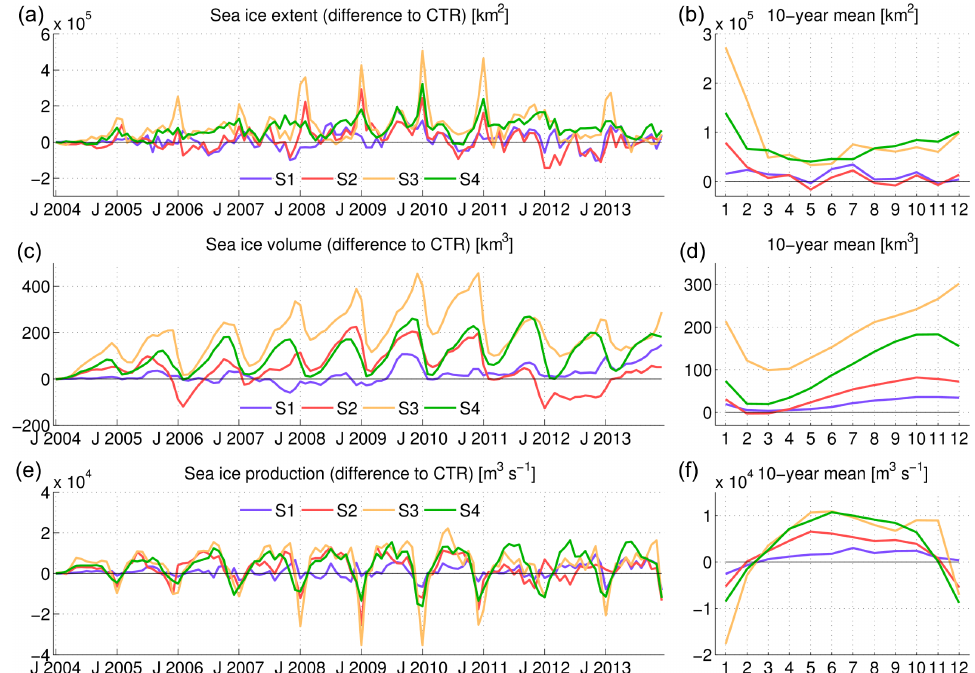
Figure 3. Time series of the differences of (a–b) sea ice extent, (c–d) sea ice volume, and (e–f) sea ice production between respective experiment and CTR: monthly values for 2004–2013 (left column) and monthly values averaged over the 10-year period (right